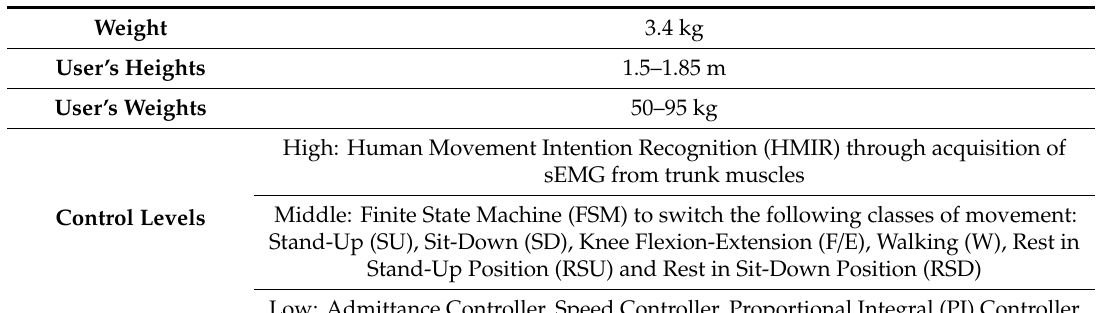
Table 1. Features of Advanced Lower-Limb Orthosis for Rehabilitation (ALLOR) regarding its structure and control